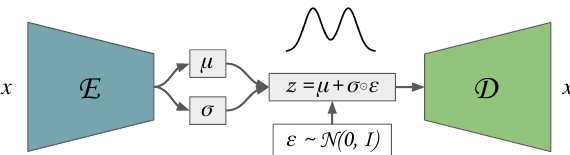
Figure 4: Architecture used for the GMVAE. The encoder and decoder are the same as for the (V)AE shown in Fig. 2c. In contrast to the standard VAE, the prior distribution is learnable and can be